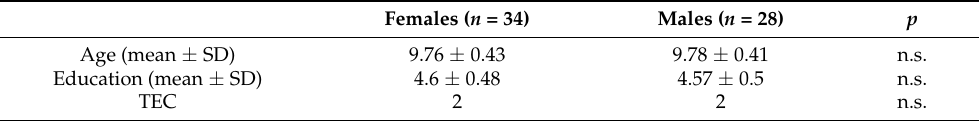
Table 1. Demographic information (mean ± standard deviation) and TEC scores on the investi- gated